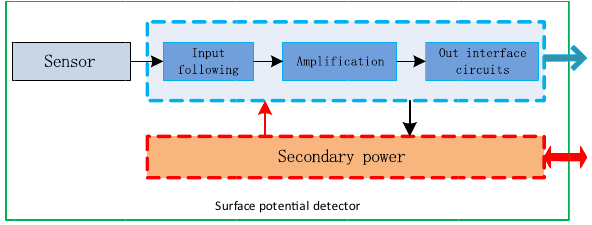
Figure 10: Schematic block diagram of internal circuit of charge